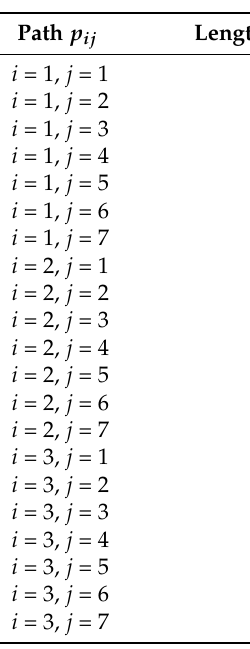
Figure 5. Function diagram of evacuation number and evacuation time. Table 3. Parameter values of each evacuation